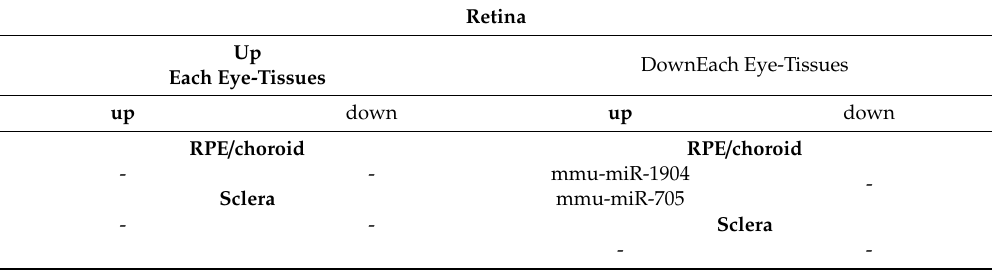
Table 5. Overlapping expression changes in miRNAs in retina and other ocular tissues.